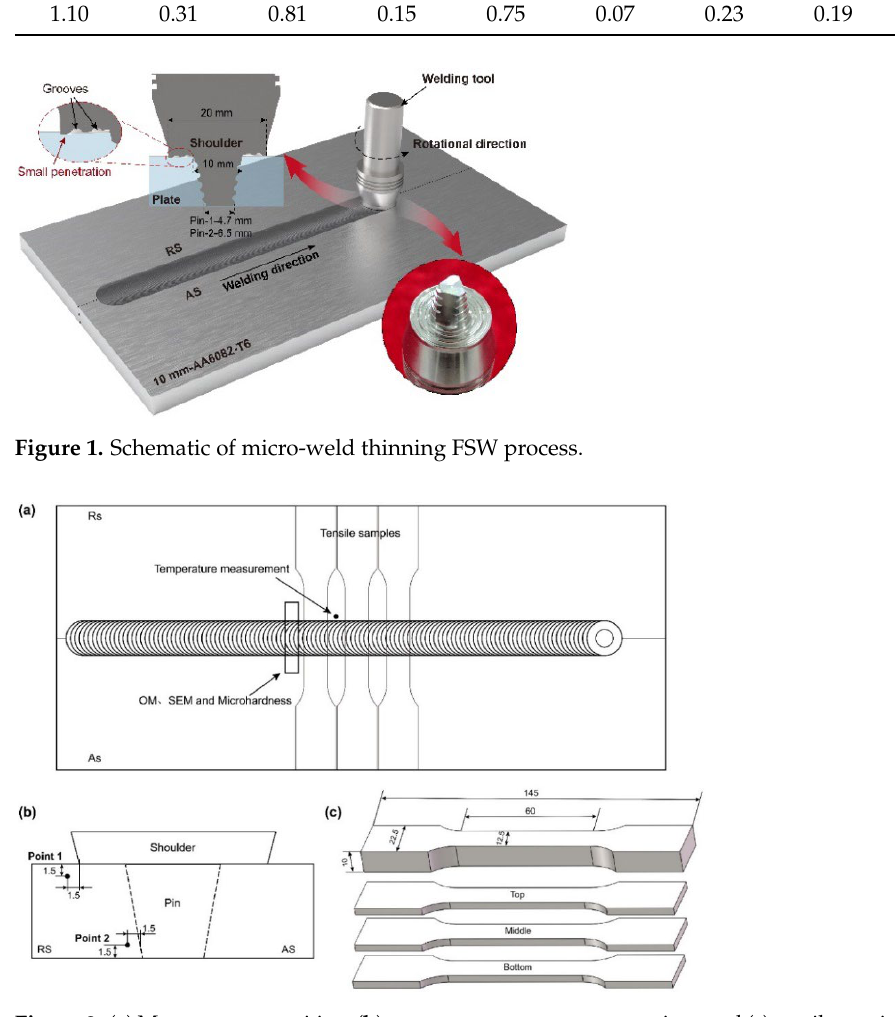
Figure 2. ( a ) Measurement position, ( b ) temperature measurement points, and ( c ) tensile specimens (mm). The microhardness maps were measured using a microhardness tester (HXD-1000TM, Shanghai, China) with a testing load of 200 g and a dwelling time of 10 s. The distance between two adjacent indentations in each row was 1 mm. The tensile properties were tested at room temperature using an tensile tester (Instron 5569, Boston, MA, USA) with a crosshead speed of 2 mm/min. The dimension of tensile samples of the whole joint was 145 mm × 12.5 mm × 10 mm, according to GB/T 228.1-2010. The tensile samples were sliced into three equal layers with a thickness of 3.2 mm to analyze the tensile properties of different regions, the detailed geometry of which can be found in Figure 2c. The tensile fracture features were observed using